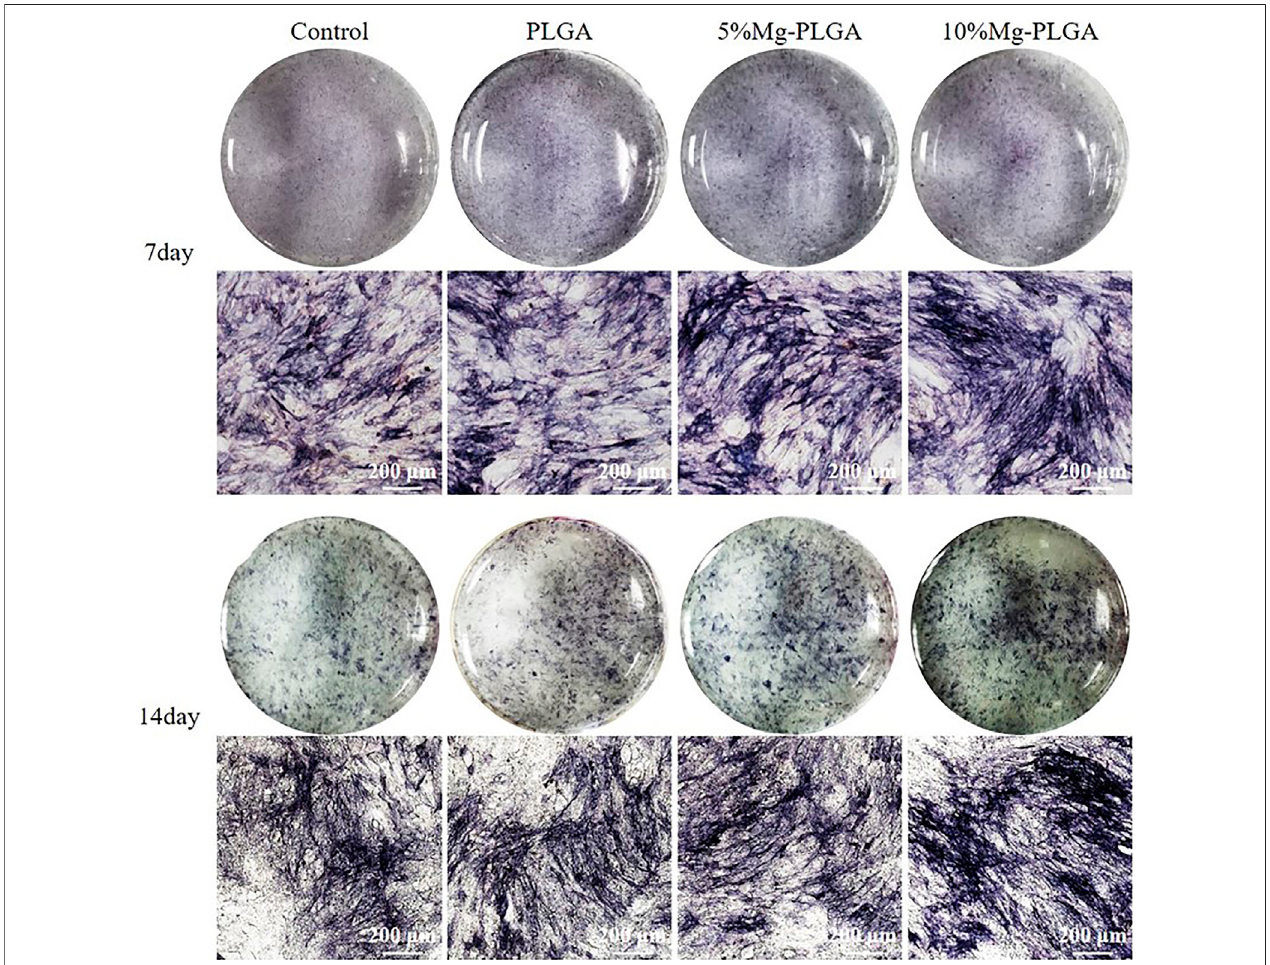
FIGURE 7 | It showed the ALP staining of MC3T3 cells cultured with PLGA, PLGA with 5% magnesium, and PLGA with 10% magnesium for 7 and 14 days, respectively. With the increasing of the ratio of magnesium, ALP activity increased correspondingly.